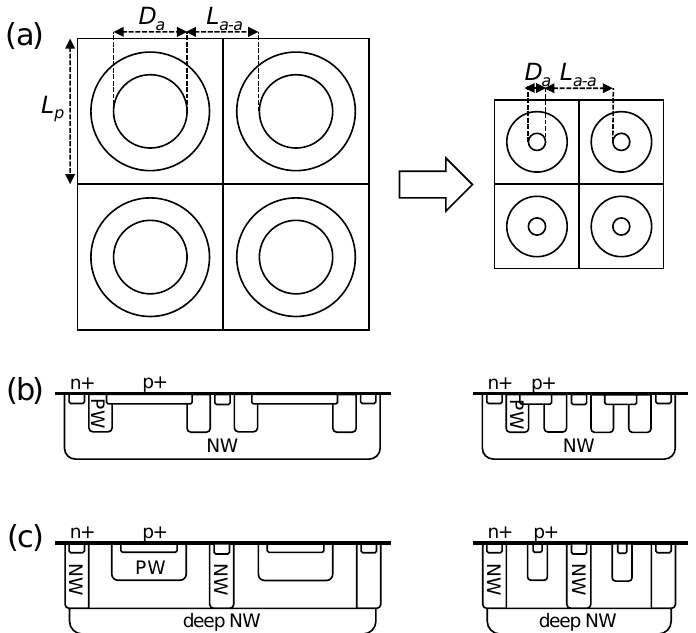
Figure 1. Conceptual views of SPAD pixel scaling; ( a ) top-view layout examples of pixel miniatur- ization, ( b ) cross-section example of p+/NW SPAD, and ( c ) cross-section example of PW/deep-NW SPAD or p-i-n